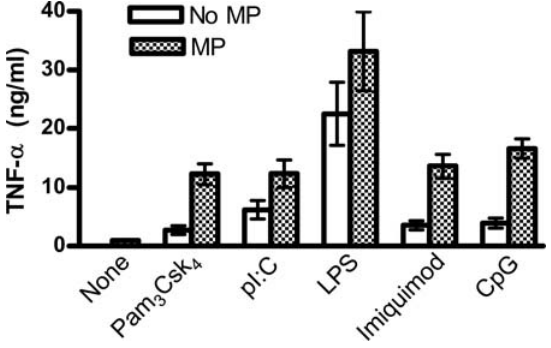
Figure 4. MP synergizes with multiple TLR ligands. cDCs were incubated for 24 hours with 10 m g/ml MP, 10 m g/ml Pam 3 CSK 4 , 10 m g/ ml pI:C, 1 m g/ml LPS, 10 m g/ml imiquimod, and 10 ug/ml CpG. Supernatants were collected and analyzed for TNF- a by ELISA. Data represent means 6 SEM of 4 independent experiments, each of which was performed in singlicate. p , 0.001 comparing any TLR ligand alone with the TLR ligand plus MP by the two-tailed paired